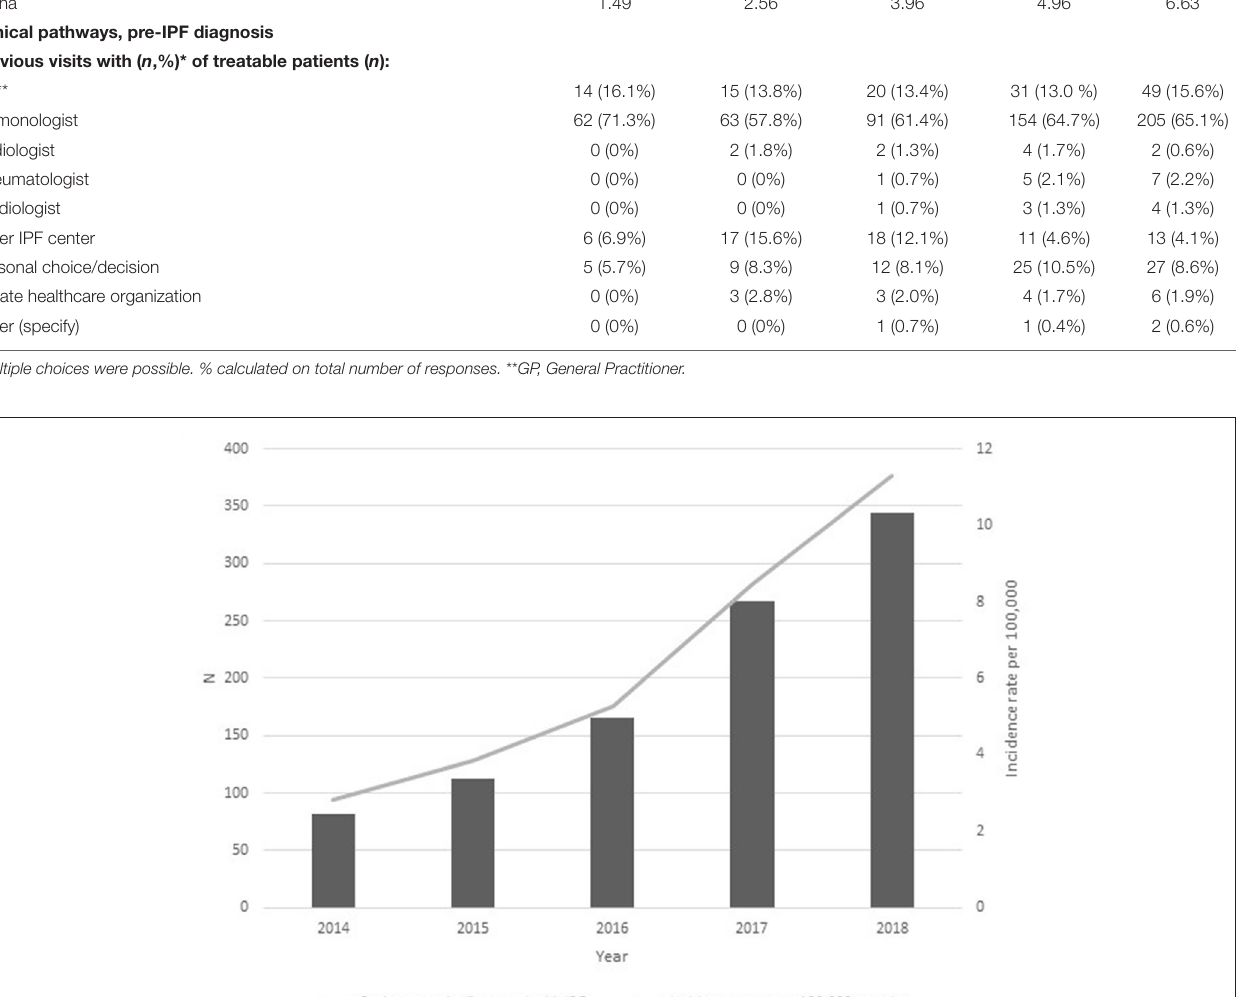
Frontiers in Medicine |